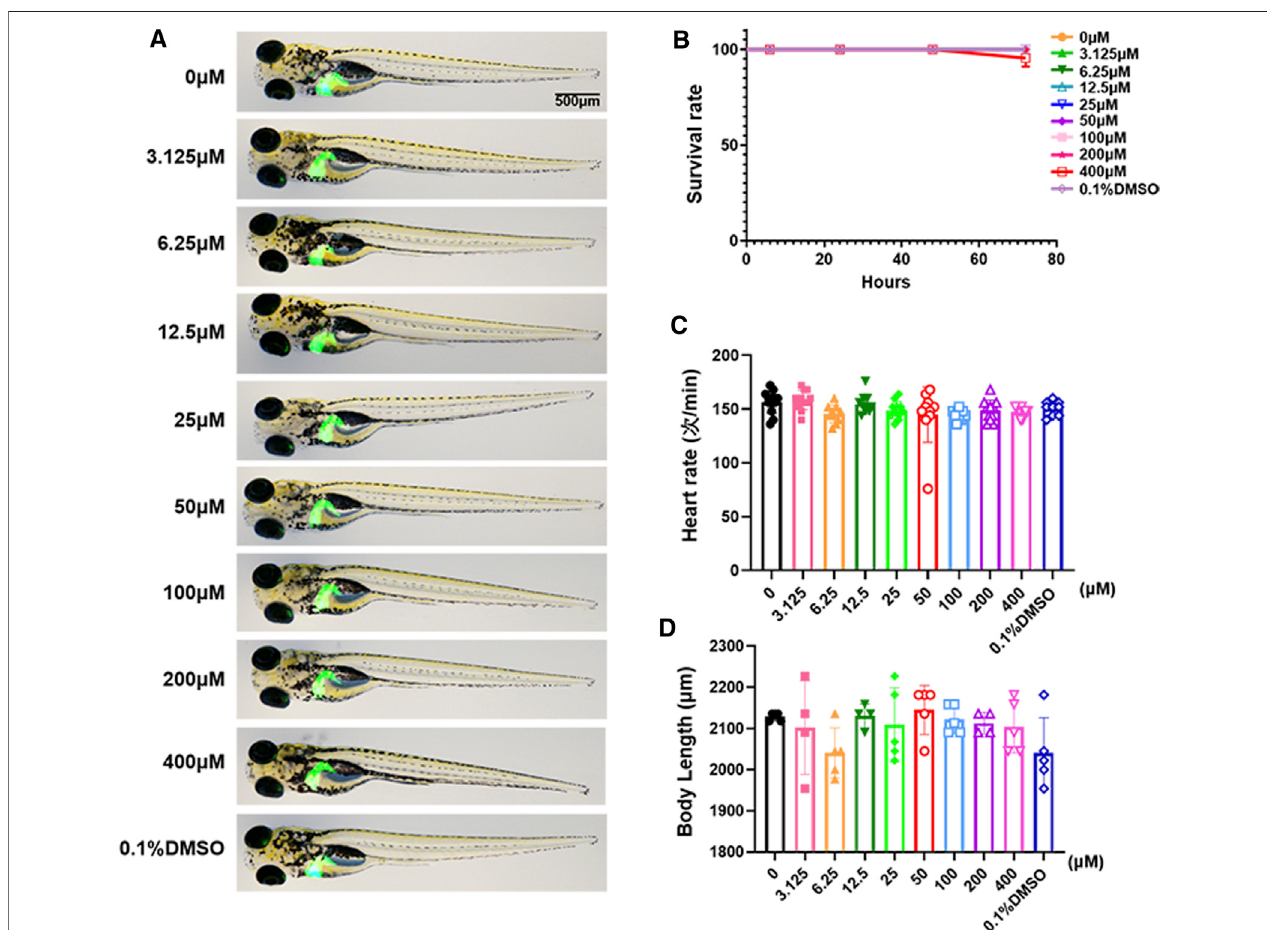
FIGURE 2 | Toxicology of limonin in zebra fi sh larvae. (A) The effect of zebra fi sh larvae exposed to different concentrations of limonin for 72 h on zebra fi sh larval morphologyandliverdevelopment( n (cid:1) 6pergroup) (B) Theeffectofdifferentconcentrationsoflimoninonthesurvivalrateofzebra fi shlarvae( n (cid:1) 22pergroup). (C) Heart rateofzebra fi shlarvaeexposedtodifferentconcentrationsoflimonin( n (cid:1) 9 – 13pergroup). (D) Thebodylengthofzebra fi shlarvaeexposedtodifferentconcentrationsof limonin ( n (cid:1) 4 – 6 per group). The data are shown as mean ± SD.